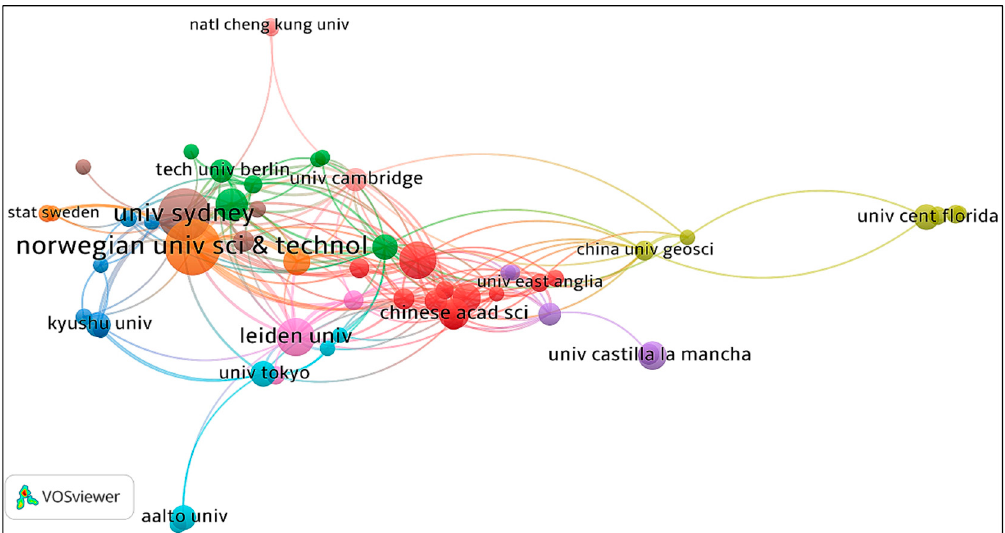
Figure 5. Network map of institution collaboration.